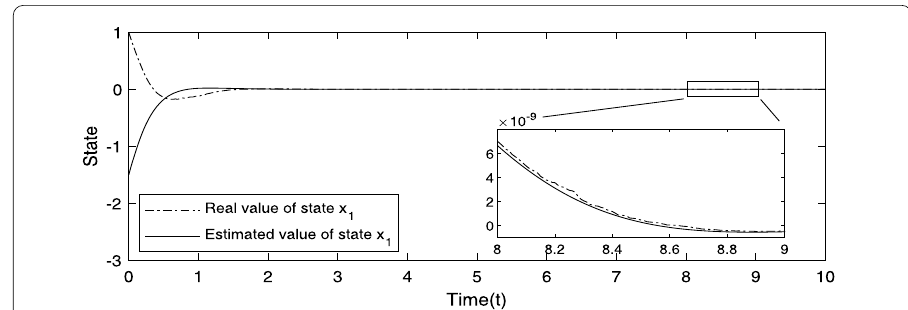
Figure 5 The simulation for state x 1 of the closed-loop systems with uncertainties